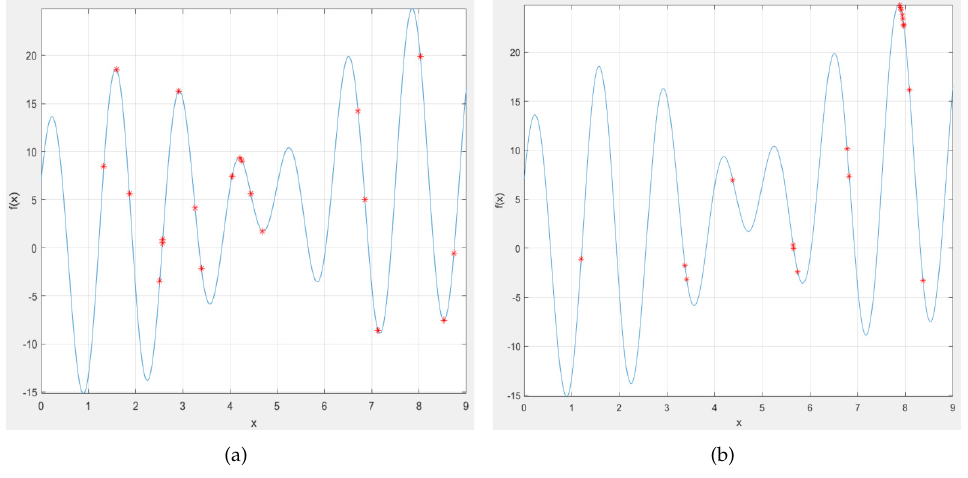
Figure 14. The comparative diagram of evolution before and after. ( a ) the initial distribution of evolutionary population; ( b ) the distribution of evolutionary population after 100 generations.